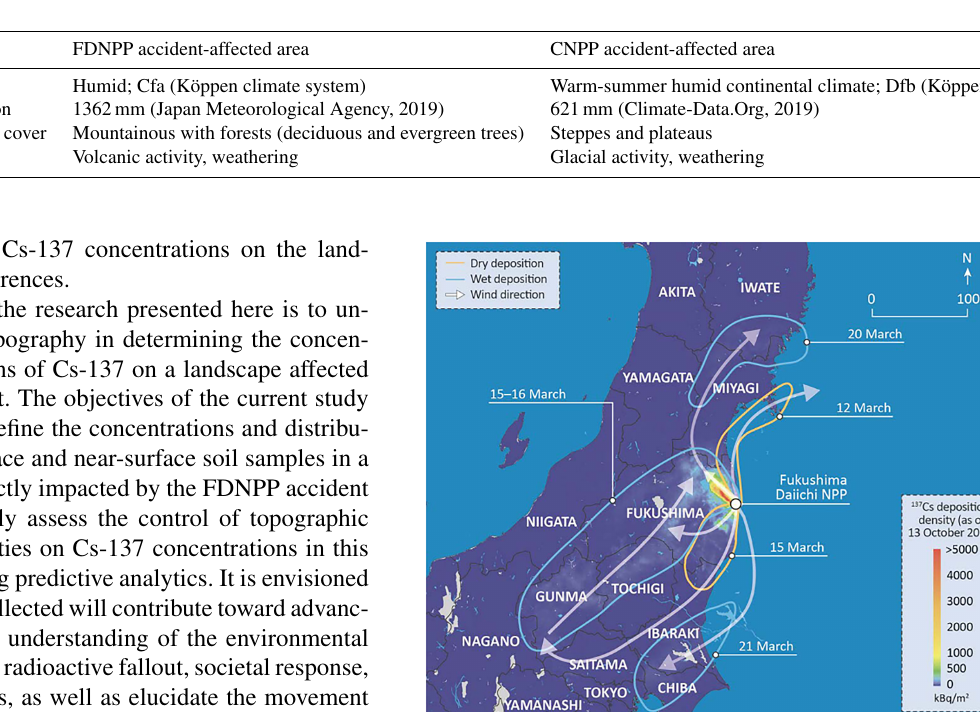
Figure 1. Locations of the FDNPP and the study site (Basemaps: a ESRI, HERE, Garmin, © OpenStreetMap contributors, and the GIS community; b ESRI Japan). Table 2. A comparison of climates, topographies, and soil formations between the FDNPP accident-affected area and the CNPP accident- affected area.